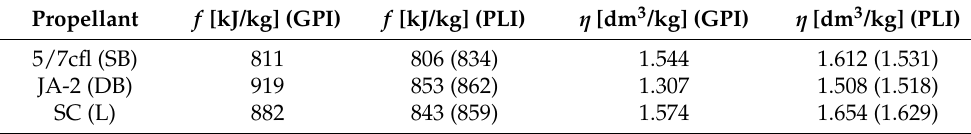
Table 2. Propellant force f and co-volume η